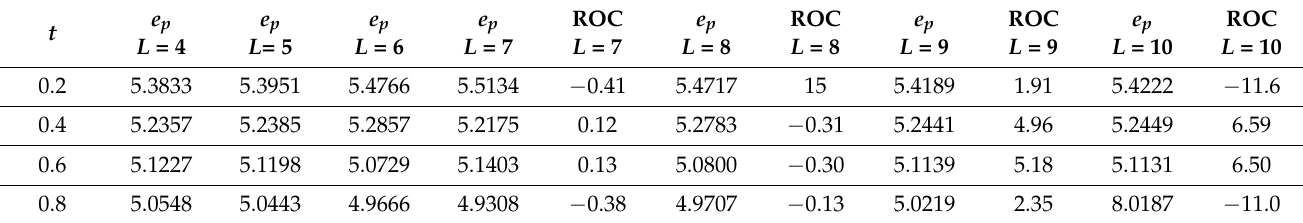
Table 9. The values of e p and rate of convergence (ROC) at different points for k = 0 and various values of L by sine– cosine wavelets.